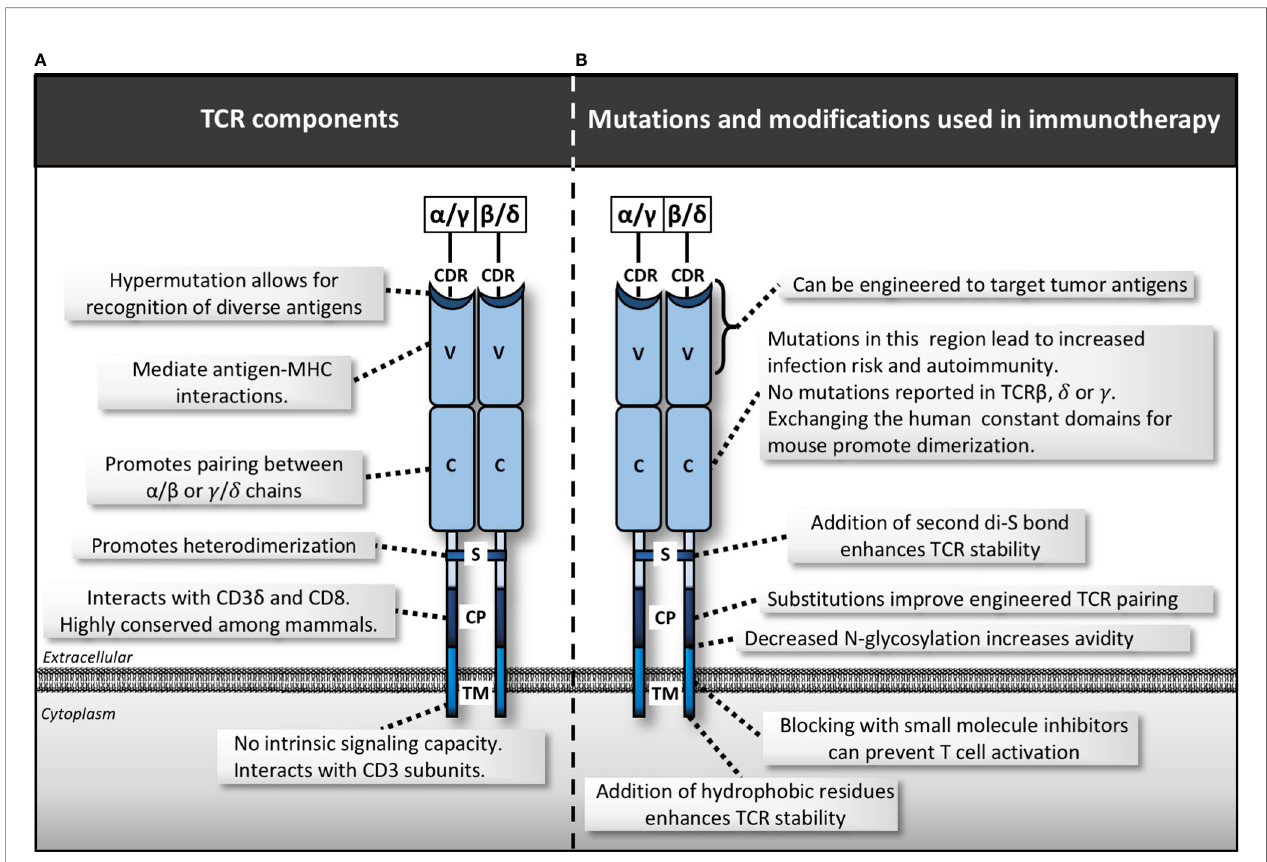
FIGURE 2 | TCR complex structure, mutations and manipulations for immunotherapy. (A) Various domains within the T cell receptor (TCR) including the complementarity-determining region (CDR), variable domain (V), constant domain (C), disul fi de bond (S), membrane-proximal connecting peptides (CP) and transmembrane (TM). (B) Mutations and modi fi cations used in immunotherapy by